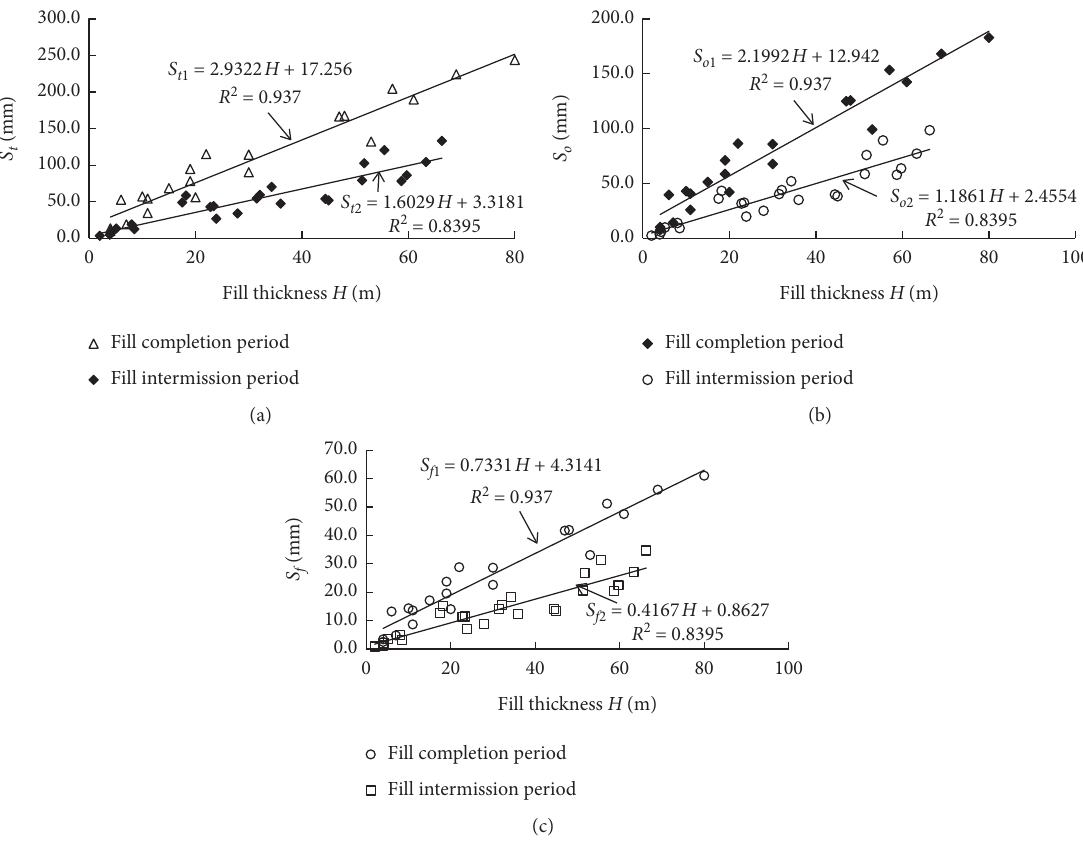
Figure 13: Relationship between S t , S o , S f , and H . (a) Curves of S t - H. (b) Curves of S o - H. (c) Curves of S f - H .